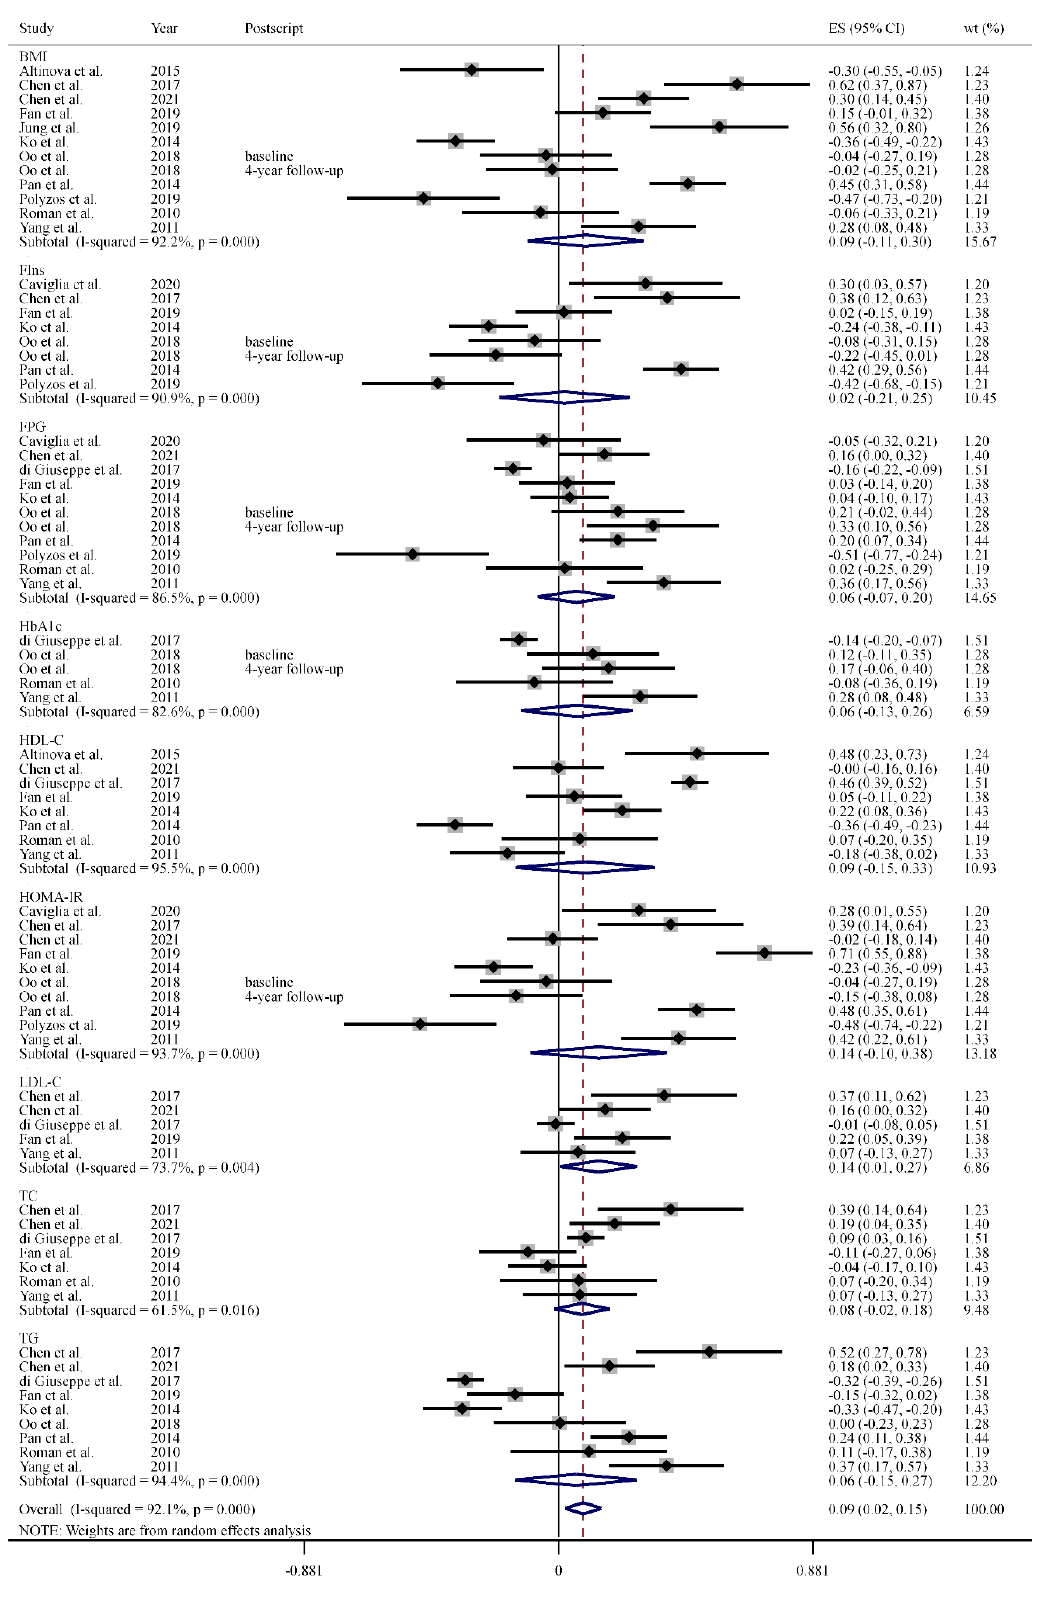
Figure 3. Correlations between selenoprotein P and 9 GLM markers. Abbreviations: ES, effect size; FIns, fasting insulin; FPG, fasting plasma/serum glucose; GLM, glucose and lipid metabolism; HDL-C, high-density lipoprotein cholesterol; LDL-C, low-density lipoprotein cholesterol; TC, total cholesterol; TG, triglyceride; wt,